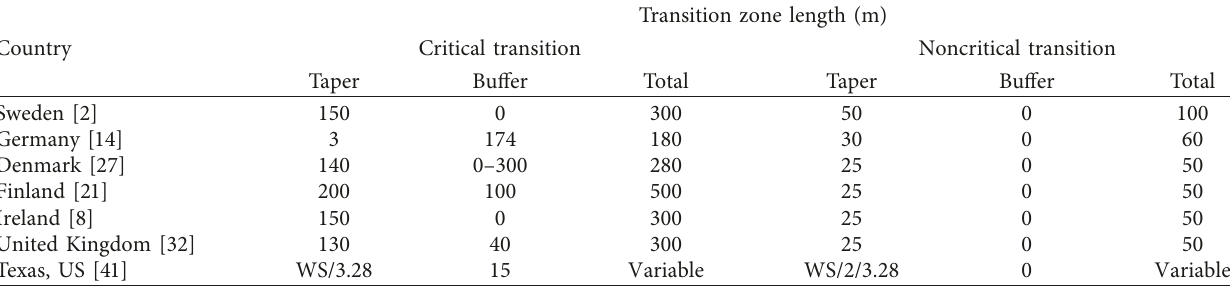
Table 4: Comparison of international transition zone